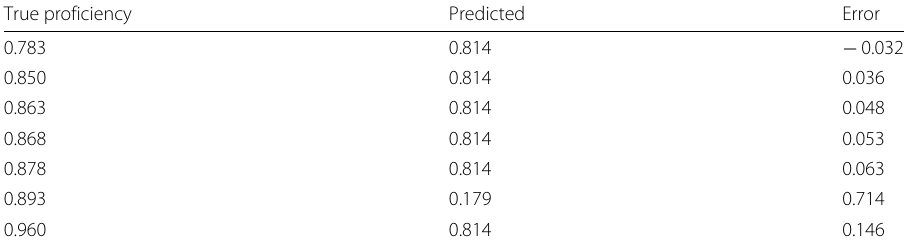
Table 9 Sample error values ( CAT_AVG simulation, class A) True